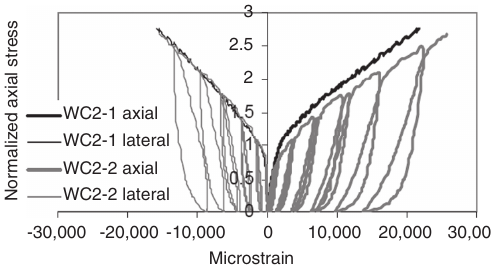
Figure 1 Stress-strain curves for WC2